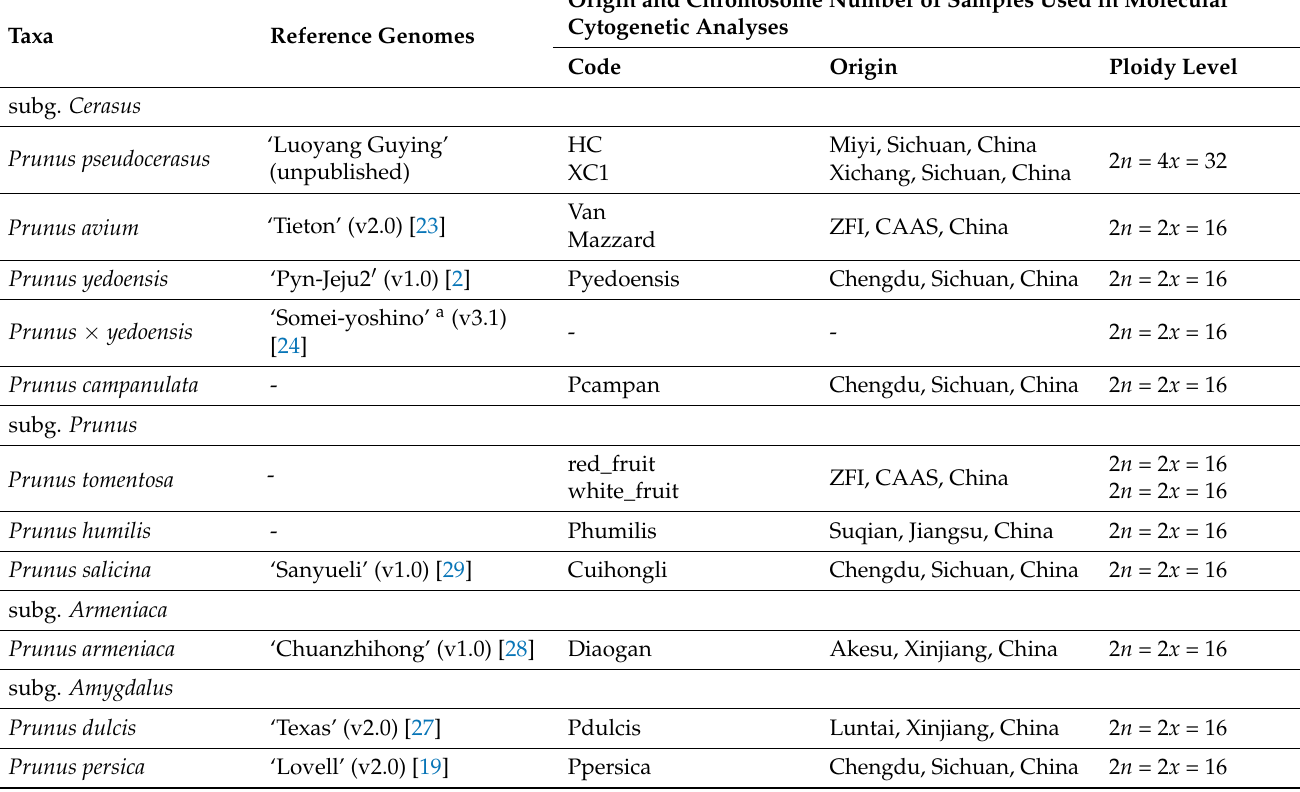
Table 1. Reference genomes and sample information used for comparative genomics and molecular cytogenetics in this